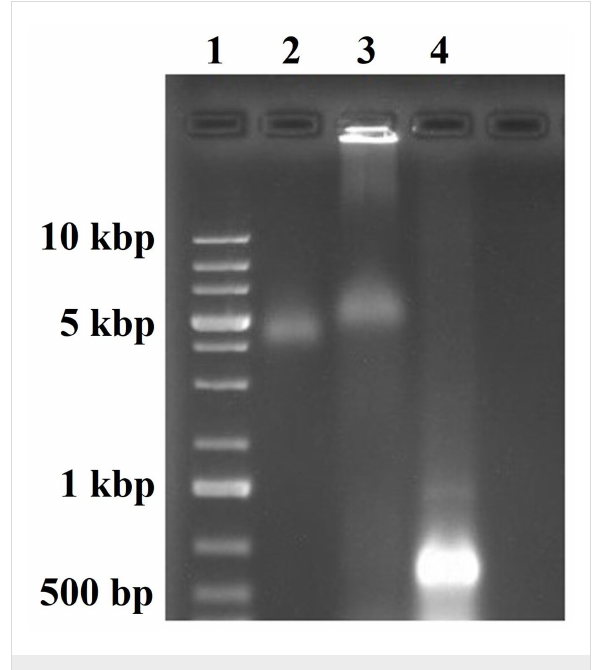
Figure 1: Analysis of the VLP-dsRNAvp28 assembly by electrophore- sis mobility shift assay (EMSA) in a 1% native agarose gel. Lane 1 is the DNA ladder; 2: wild type CCMV; 3: self-assembly of dsRNA with CCMV CP; and lane 4: free